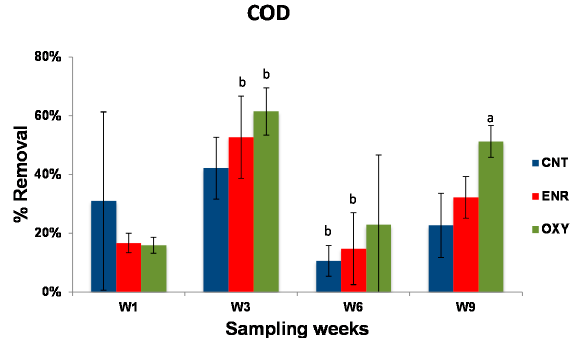
Figure 3. Chemical Oxygen Demand (COD) values in initial and CWs treated wastewaters along the sampled weeks. Wastewater not doped (CNT) or doped with the antibiotic enrofloxacin (ENR) or oxytetracycline (OXY). a: Significant differences ( p < 0.05) compared to CNT; b: Significant differences ( p ≤ 0.05) compared to the same treatment the week before.